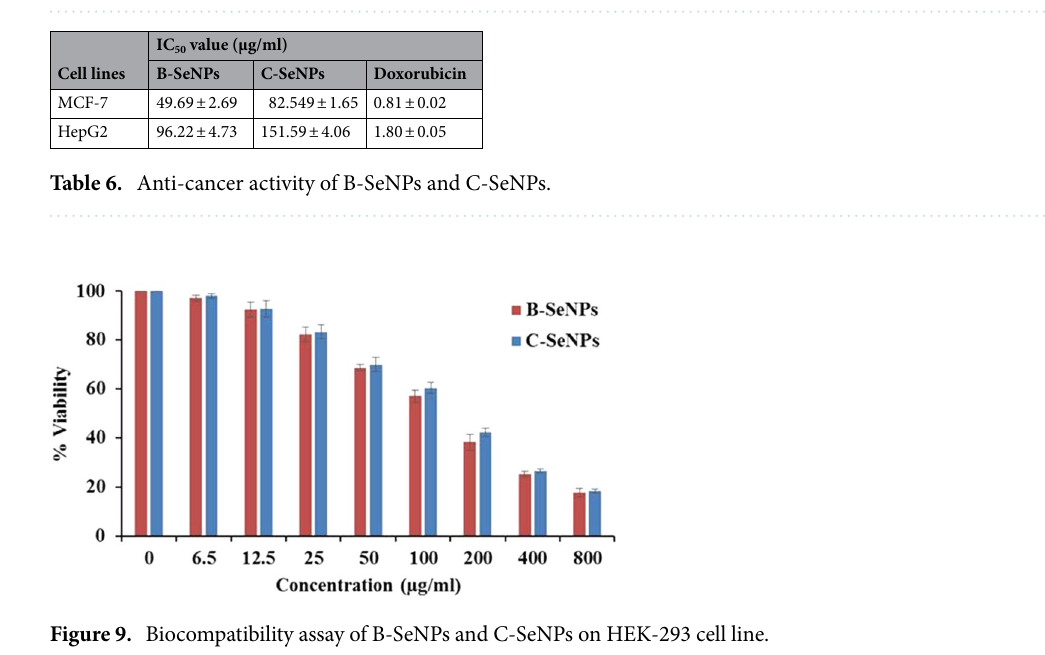
Figure 8. Comparative anti-cancer activity of B-SeNPs and C-SeNPs ( a ) MTT assay of HepG2 ( b ) MTT assay of MCF-7 ( c ) MTT assay of doxorubicin ( d ) Images before and after treatment of SeNPs for 24 h.